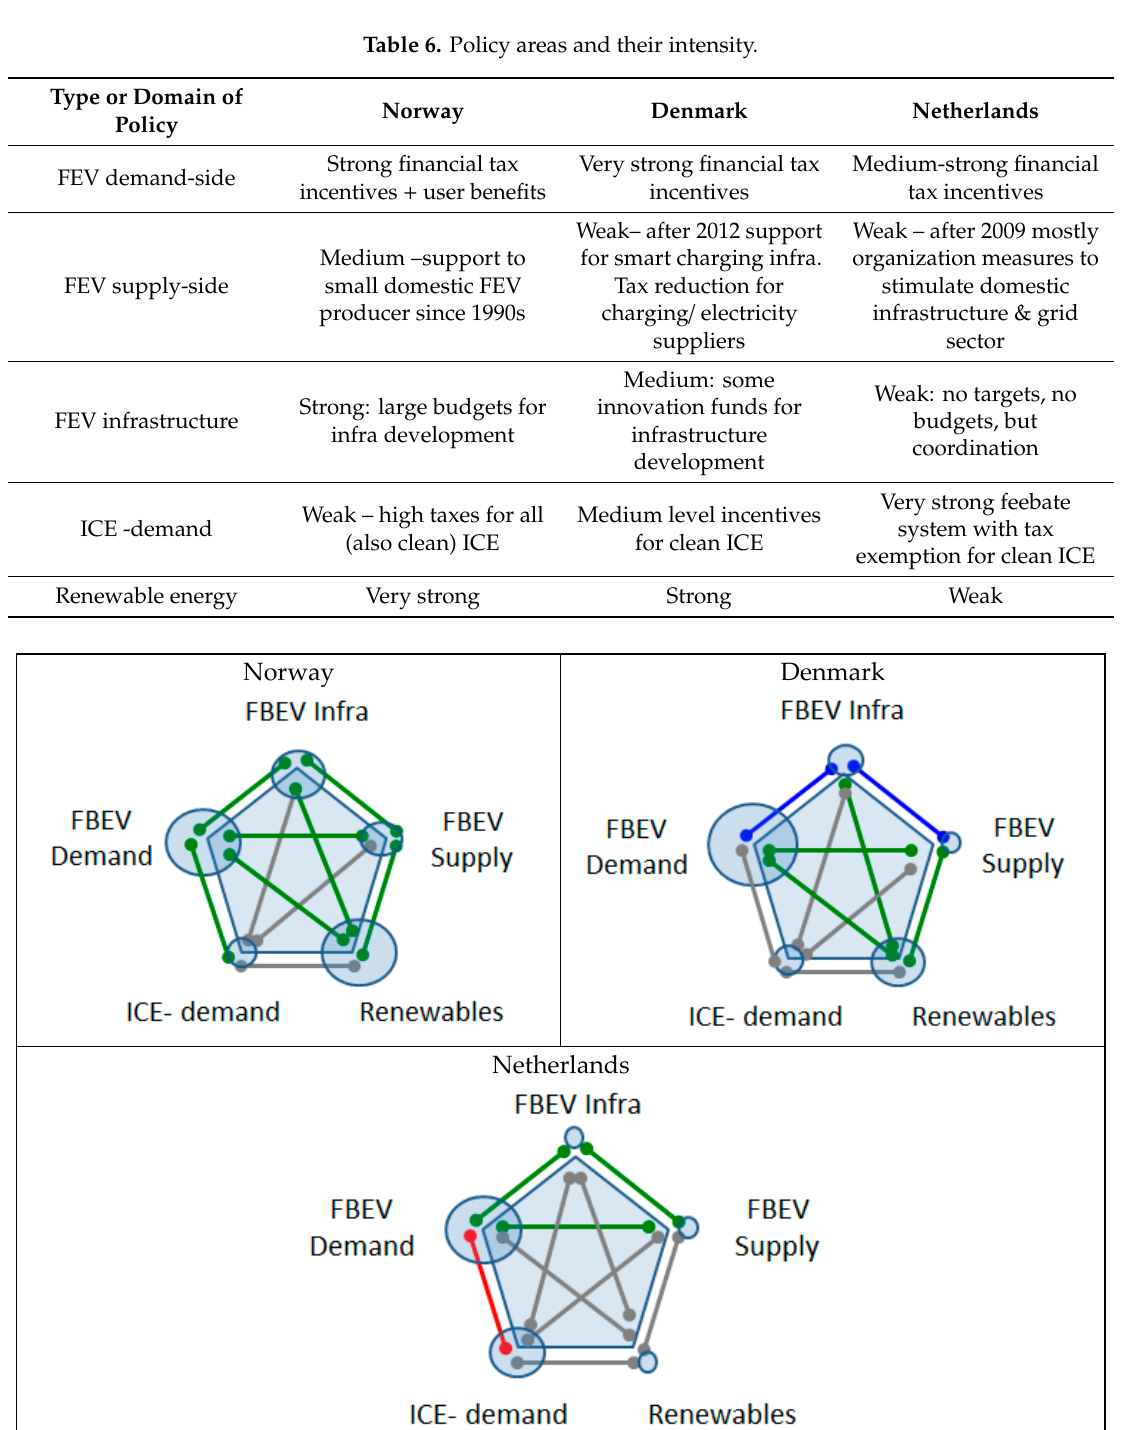
Figure 2. Relationships in the national policy mixes (precondition in blue, synergy in green, contradictory in red, neutral in grey). The size of the balloons reflects the intensity of the policy, as indicated in Table 6. Table 6. Policy areas and their intensity.